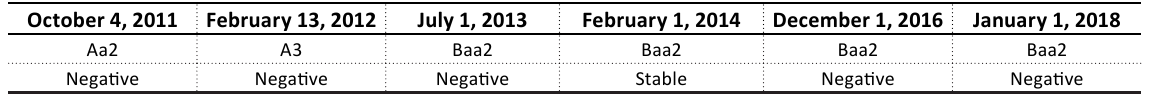
Table 4. Changes in sovereign rating of Italy (Moody’s)